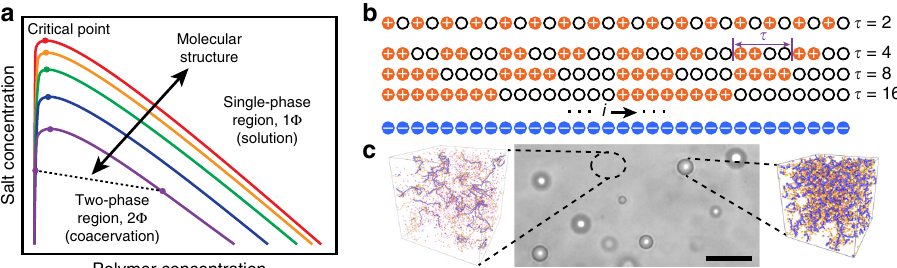
Fig. 1 Molecular structure and sequence affects charge-driven phase separation. a Qualitative sketch of a typical phase diagram of complex coacervate- forming polyelectrolytes. Coacervation occurs at low salt and polymer concentrations, where oppositely charged polyelectrolytes undergo a liquid-liquid phase separation into polymer dense (coacervate) and polymer-dilute (supernatant) phases. The different curves qualitatively represent how the immiscible region changes with different molecular features (charge monomer sequence, spacing, ion size, degree of polymerization, valency, etc.). b We show that charge monomer sequence is a molecular feature, which can be used to tune coacervation behavior. This simulation and experimental result is based on coacervation between a homopolyanion and a series of model, sequence-de fi ned polycations with half of their monomers charged. These polycations are characterized by the periodic repeat of the monomer sequence, τ . c Coacervation is experimentally observed as droplets of a polymer- dense ‘ coacervate ’ dispersed in a polymer-dilute ‘ supernatant ’ phase. Simulation images correspond to conditions (salt concentration, 25 mM and τ = 2) shown in Fig. 2. Scale bar is 25 μ